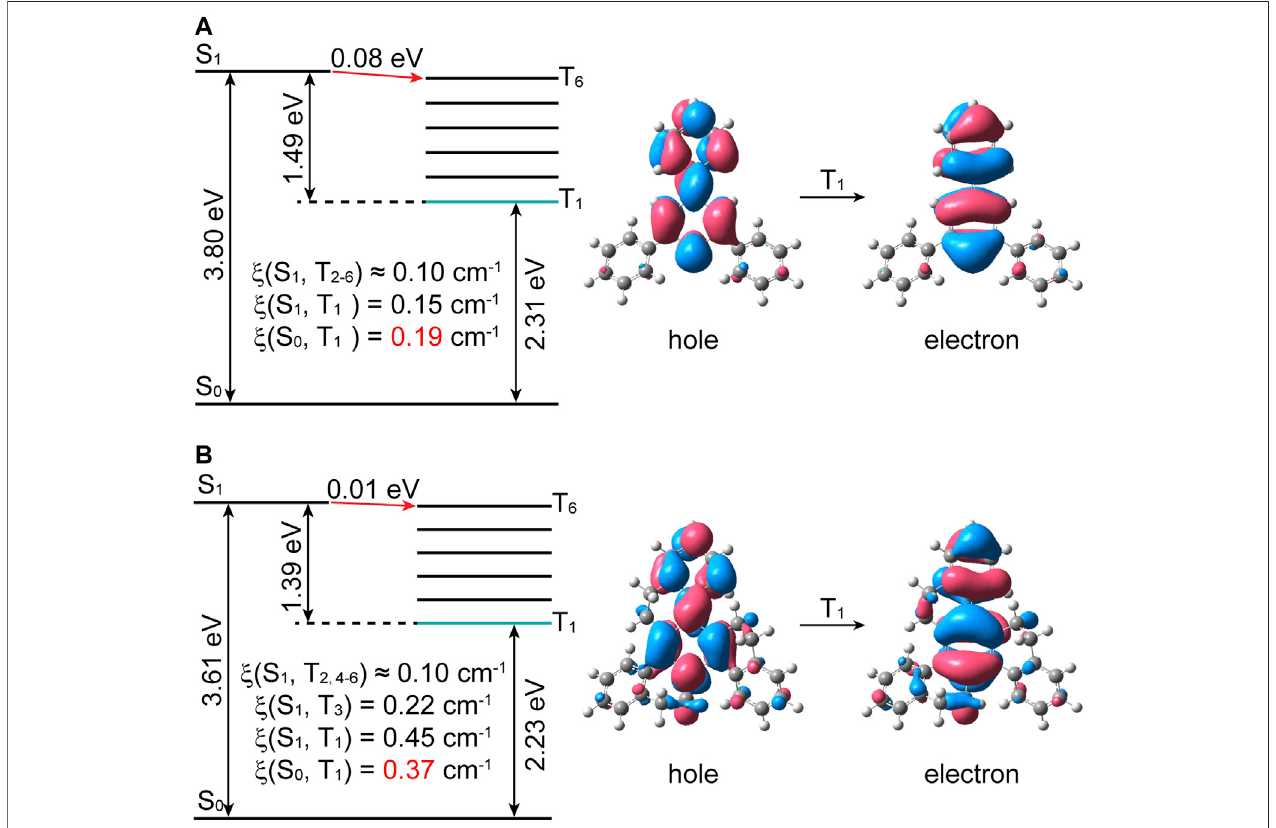
FIGURE 2 | Calculated energy diagram and SOC matrix elements ( ξ ) of the low-lying excited states, and NTOs of T 1 states for (A) PT and (B) HD.